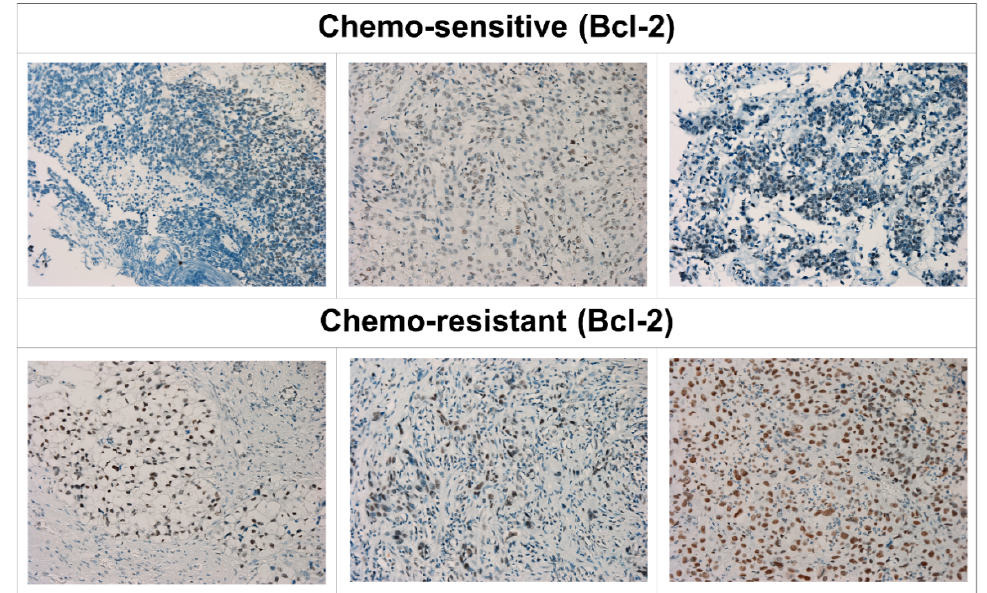
Figure 5. Bcl-2 expression in human metastatic UC cells is associated with chemo-resistance. Imunohistochemical (IHC) staining analysis of Bcl-2 from six patients with metastatic bladder UC, including three (upper part) with a chemo-sensitive and three (lower part) with a chemo-resistant status. IHC staining of formalin fixed, paraffin-embedded bladder UC tissues. The nuclear membrane and cytoplasm of chemo-resistant UC cells show intense staining with antibody to the Bcl-2 protein compared to those in chemo-sensitive UC